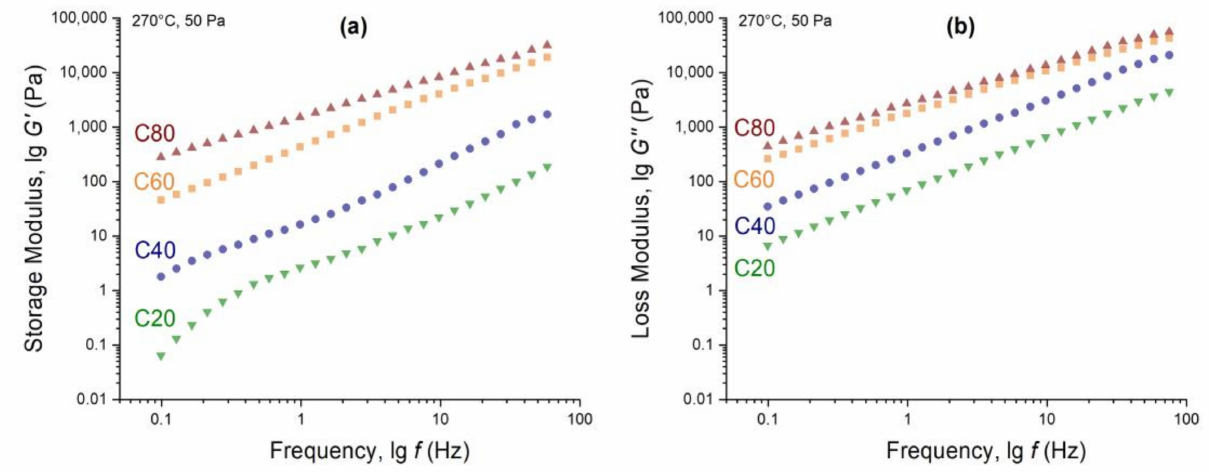
Figure 5. Dependence of the storage modulus ( a ) and loss modulus ( b ) on frequency with an amplitude of 50 Pa for C20–C80 copolyester melts at 270 ◦